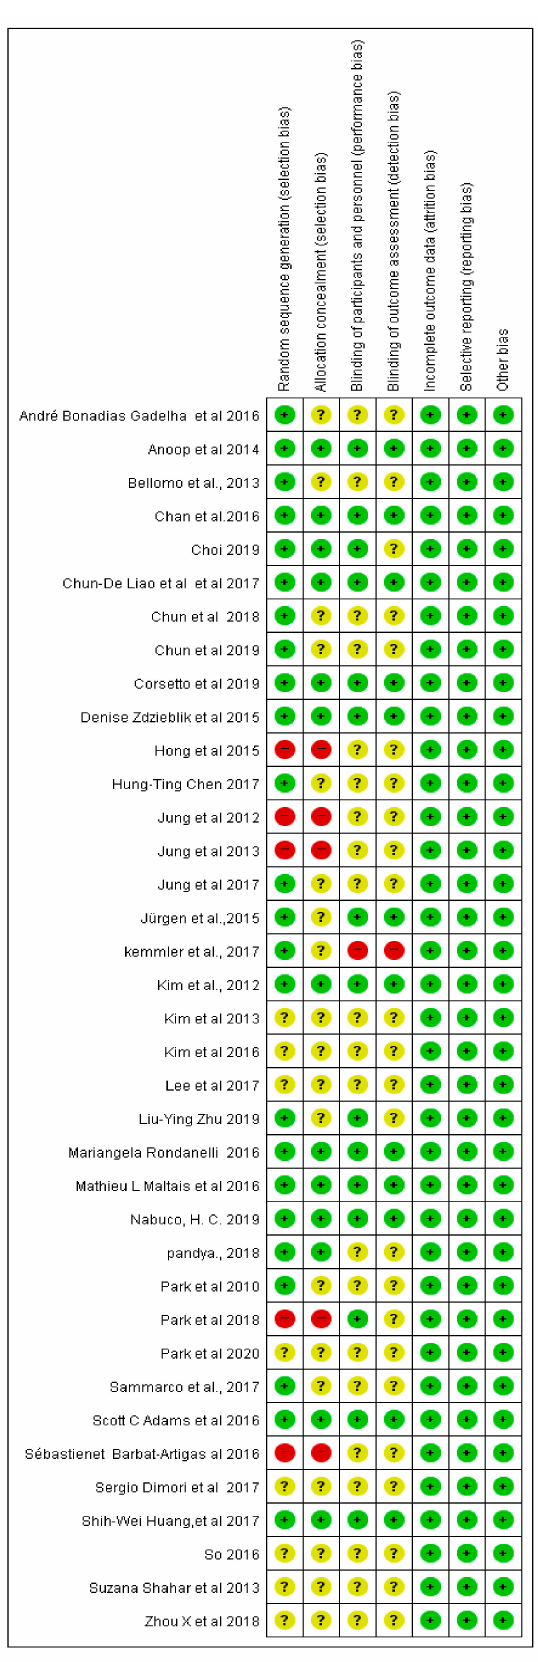
Figure 3. Risk-of-bias summary of systematic review on diagnostic tools and intervention methods for